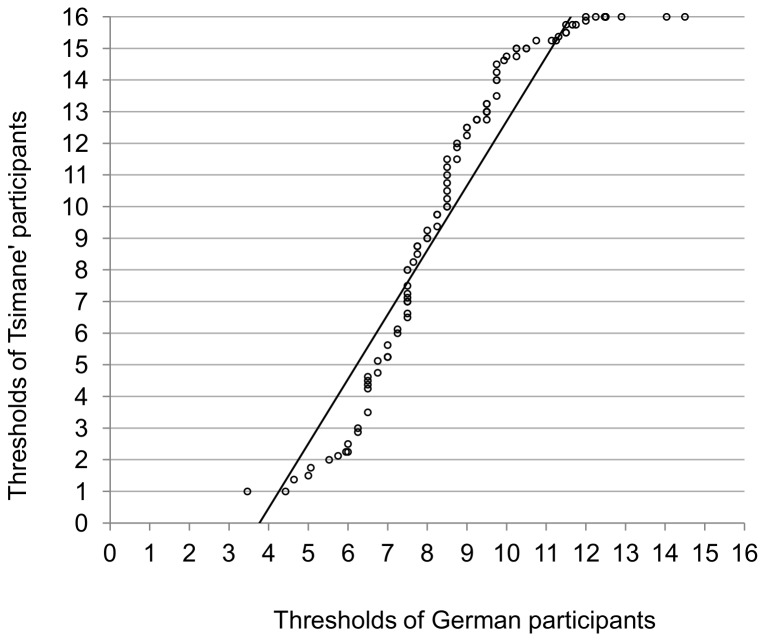
Quantile-Quantile (Q-Q) plot of odor thresholds for Tsimane’ and German participants. The solid line represents the general trend of the Q–Q plot.